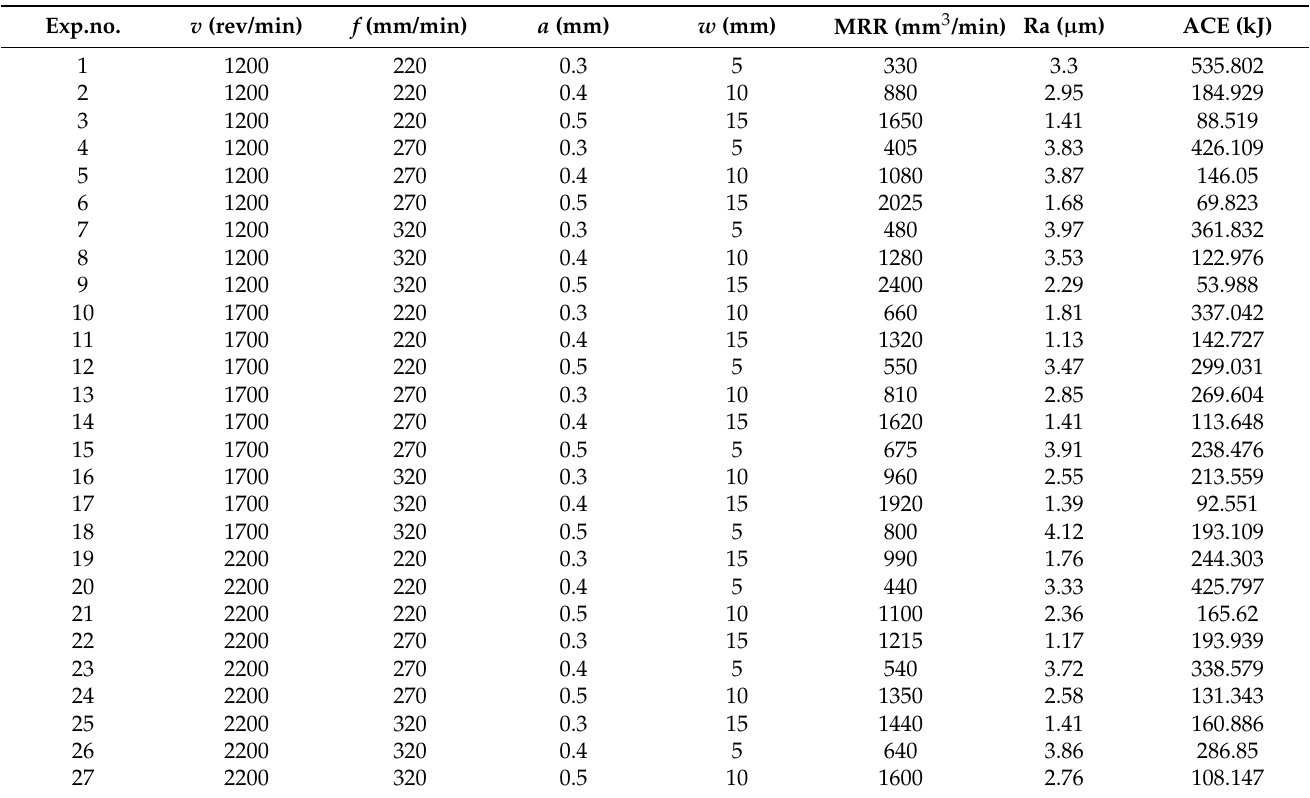
Table 8. Experimental dataset on green dry milling of AISI 1045 steel (case study 2) [24]. Exp.no.